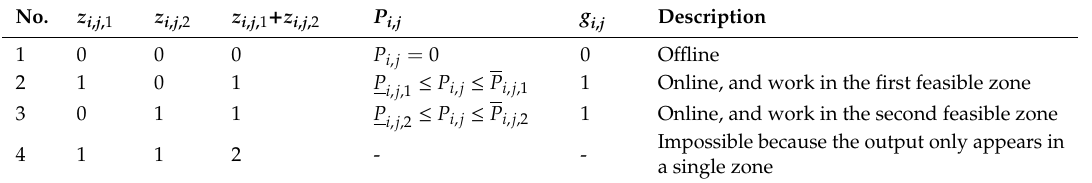
Table 1. Explanation for Equation (19) where the generator has two feasible